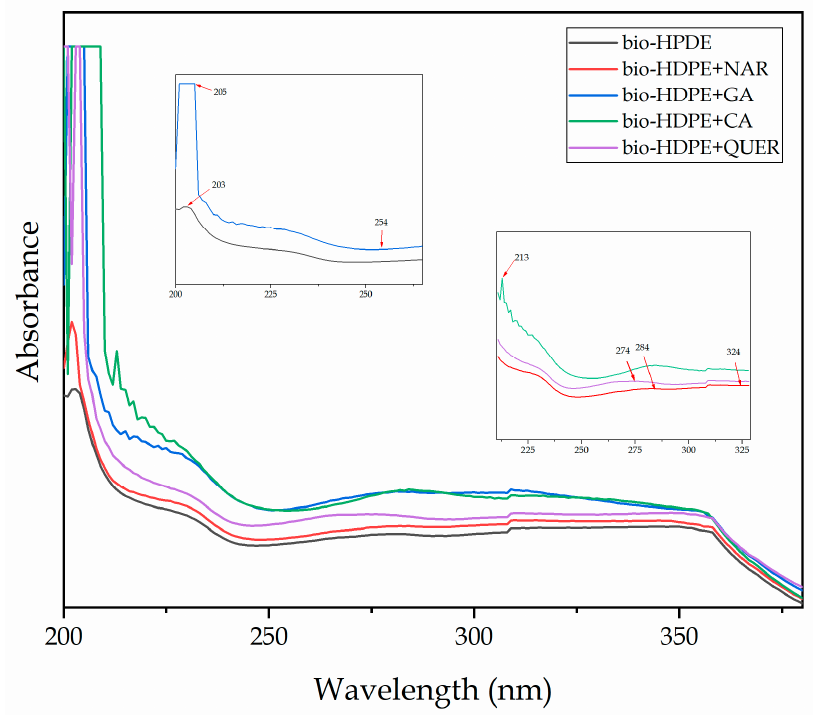
Figure 4. Ultraviolet–Visible (UV–Vis) spectra of the thermo-compressed bio-based high-density polyethylene (bio-HDPE) films containing naringin (NAR), gallic acid (GA), caffeic acid (CA), and quercetin (QUER).